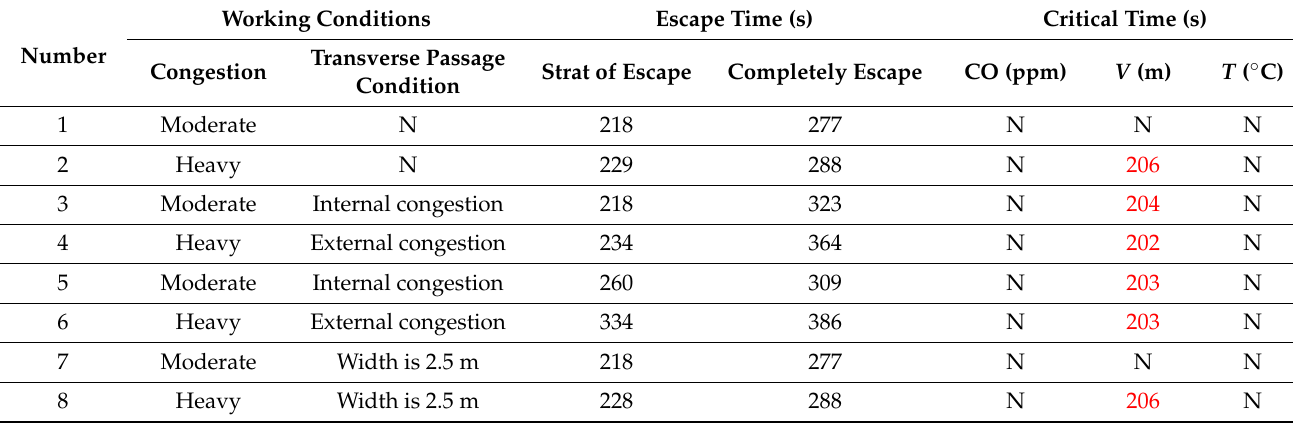
Table 1. Escape time under different working conditions.